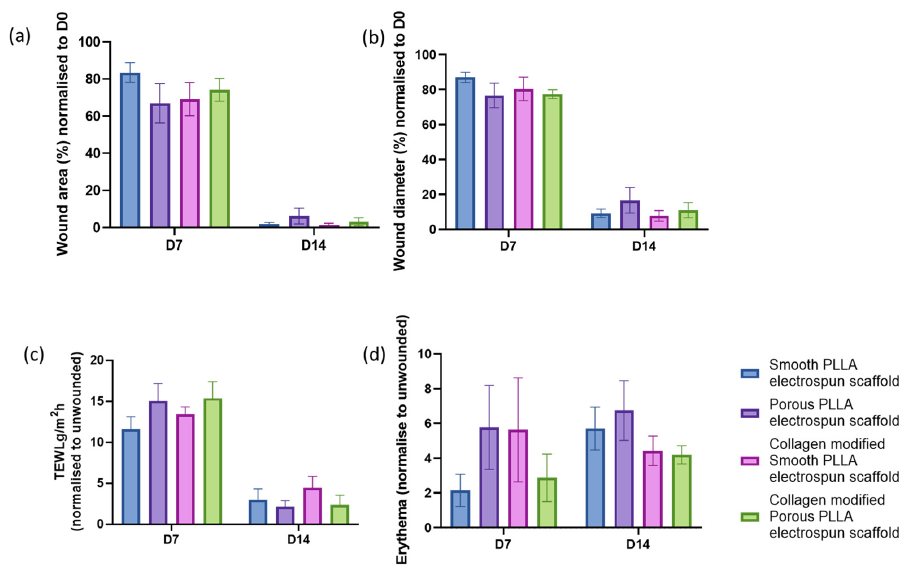
Figure 3. Quantification of macroscopic healing. Wound area ( a ) and diameter across the midline ( b ) of excisional wounds at days 7 and 14, normalised to day 0 and expressed as a percentage of initial (%). ( c ) Transepithelial water loss (TEWL) through the wound on day 0 and 7. Data expressed as g/m 2 /h normalized to unwounded skin. ( d ) Wound redness (erythema) measured on day 7 and day 14 and normalized to adjacent unwounded skin. Bars represent mean ± SEM, n = 6 mice.